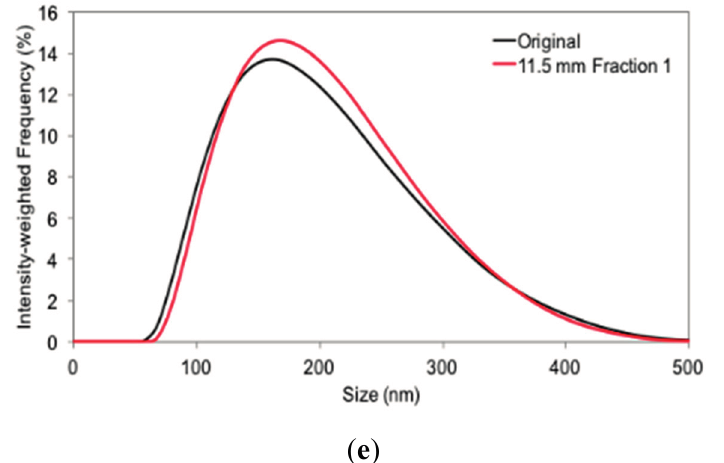
Figure 3. ( a ) Digital image of magnetic separation prototype developed to replicate the conditions of the MATLAB simulation; ( b ) Digital image of Fraction 1 ( left ) and Fraction 2 ( right ) samples collected from the magnet distances of, from top to bottom, 11.5, 10, and 7.5 mm; ( c – e ) Size distributions of the obtained samples using distances of 7.5, 10, and 11.5 mm compared to that of the original MNP